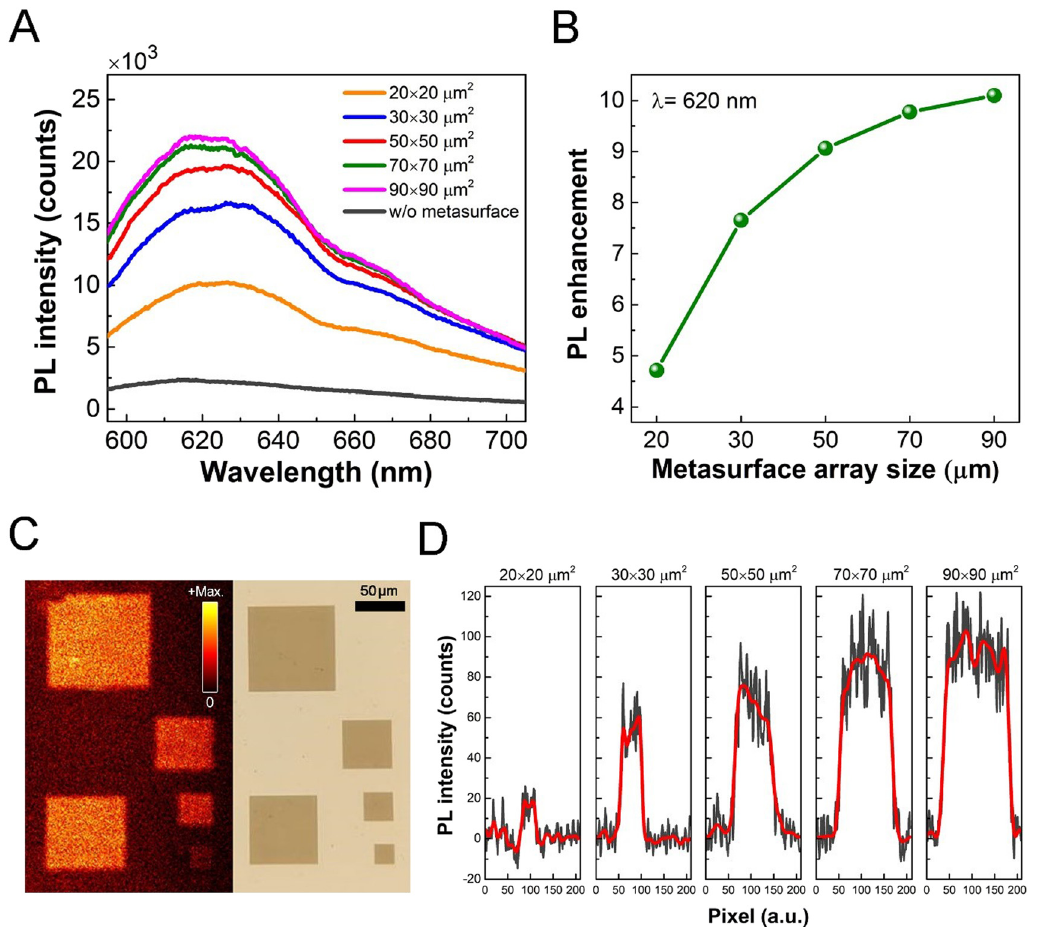
Figure 4: (A) Experimental PL intensity versusmetasurfacearray sizes.The signalmeasuredonthe unpatternedarea is plotted as a reference for comparison. (B) The PL enhancement at λ = 620 nm as a function of metasurface array size. (C) Spatial PL mapping (left) of the integrated TiO 2 -NR metasurfaces. The right image presents the corresponding microscopic image of the TiO 2 metasurfaces. (D) Cross-sectional line- scannedPLintensityatthecenterofeacharray.Notethattheresultsaredeductedfromindividualbackgroundsignalsforclarity.Blackcurves: raw data. Red curves: smoothed curve. The excitation laser wavelength is 532